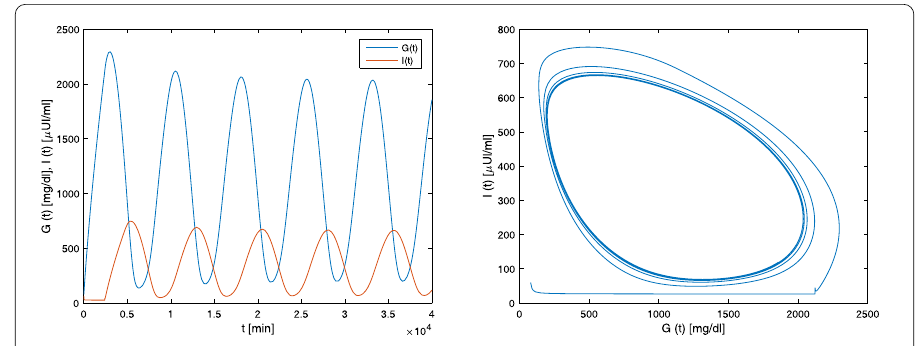
Figure 8 Time series of fractional-order model (29) generated using the information from Set 4, the parameter values in Eq. (58), and τ = 2400 > τ 0 = 2089.425. A periodic oscillation bifurcates from the equilibrium point ( G ∗ , I ∗ ) = (1018.09,334.39)